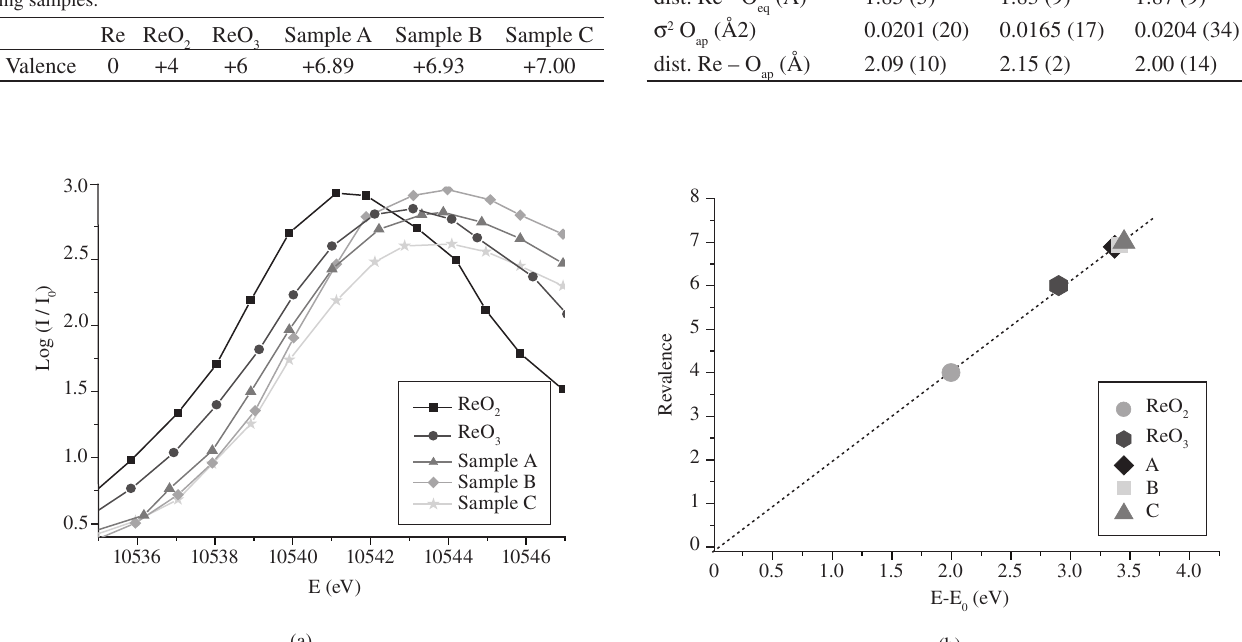
Figure 1. a) details of the Re L 1223, B and C, determined from the LIII e absorption edge displacements.